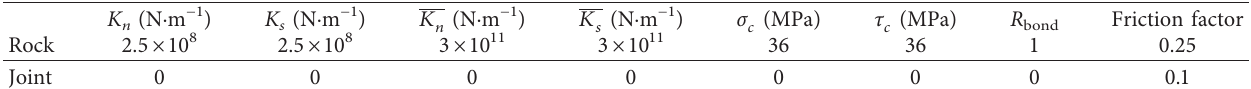
Figure 6: Microparameters and force-displacement behavior of particles in PFC2D [33], where K n and K s are normal stiffness and shear stiffness of particles, K n and K s are normal stiffness and shear stiffness of parallel bond, F n and F s are normal contact force and shear contact force between two particles, respectively; R bond is radius of parallel bond. Table 3: Calibrated microparameters of PFC2D